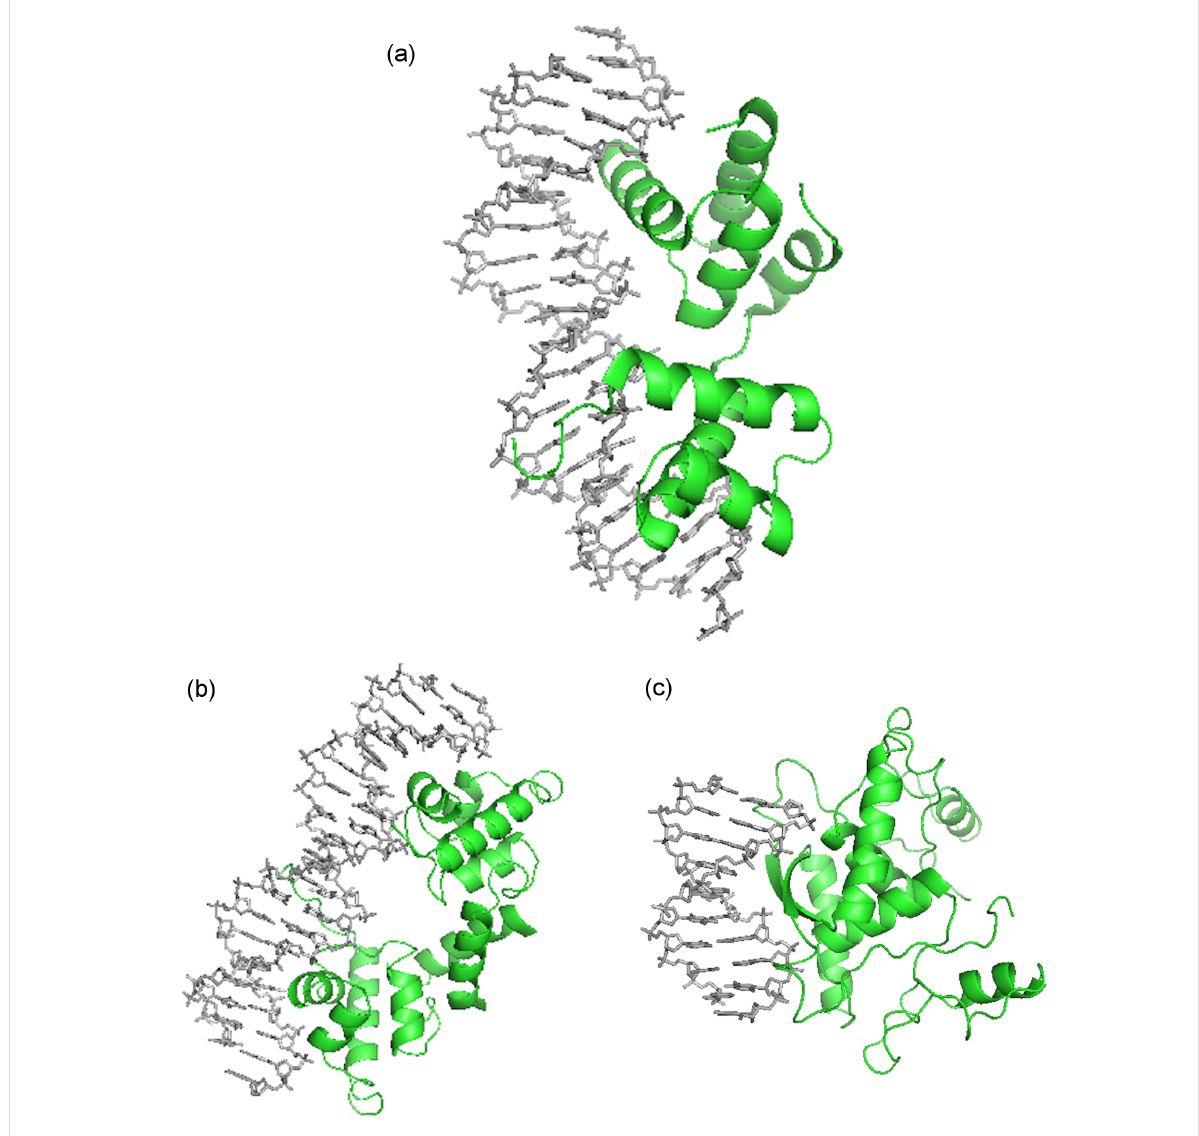
Figure 2: (a) Portions of MAT α 1–MAT α 2 are shown contacting the minor groove of the DNA substrate. Key arginine residues within this region facili- tate the interaction (PDB ID# 1AKH) [25]; (b) Figure shows DNA bound to λ repressor protein. Alpha helices of the protein dimers recognize specific sequences within the DNA major groove (PDB ID# 1LMB) [26]; (c) The MetJ dimer β sheet contacts the DNA ligand major groove via side chains on the face of the β sheet (PDB ID# 1CMA)